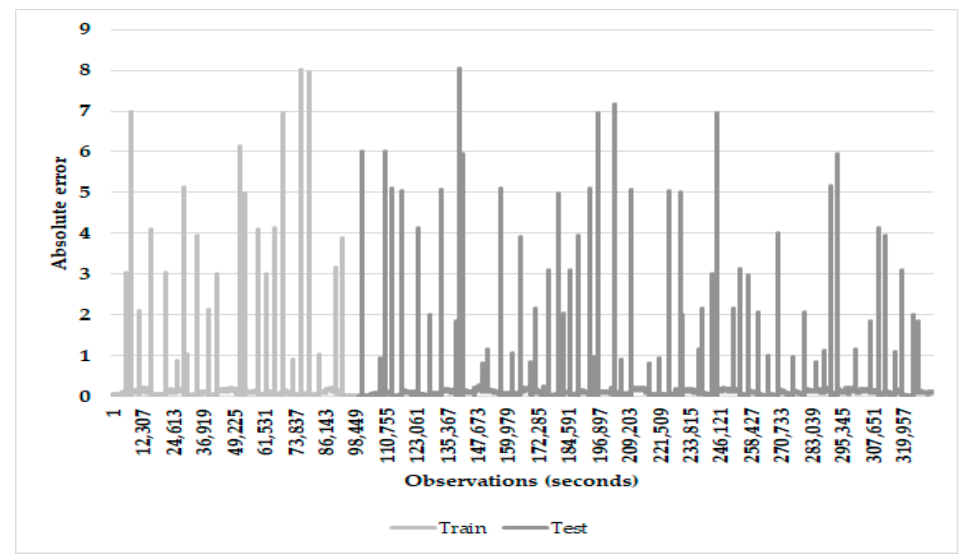
Figure 3. Absolute error versus observations in seconds for the LSTM with a 30%/70% training/testing split.